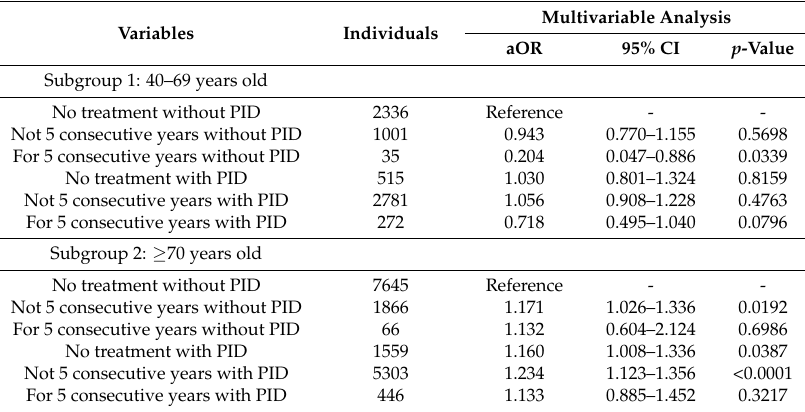
Table 2. Odds ratio of Parkinson’s disease for dental scaling * and periodontal inflammatory study among the cases and controls, with subgroup analysis.